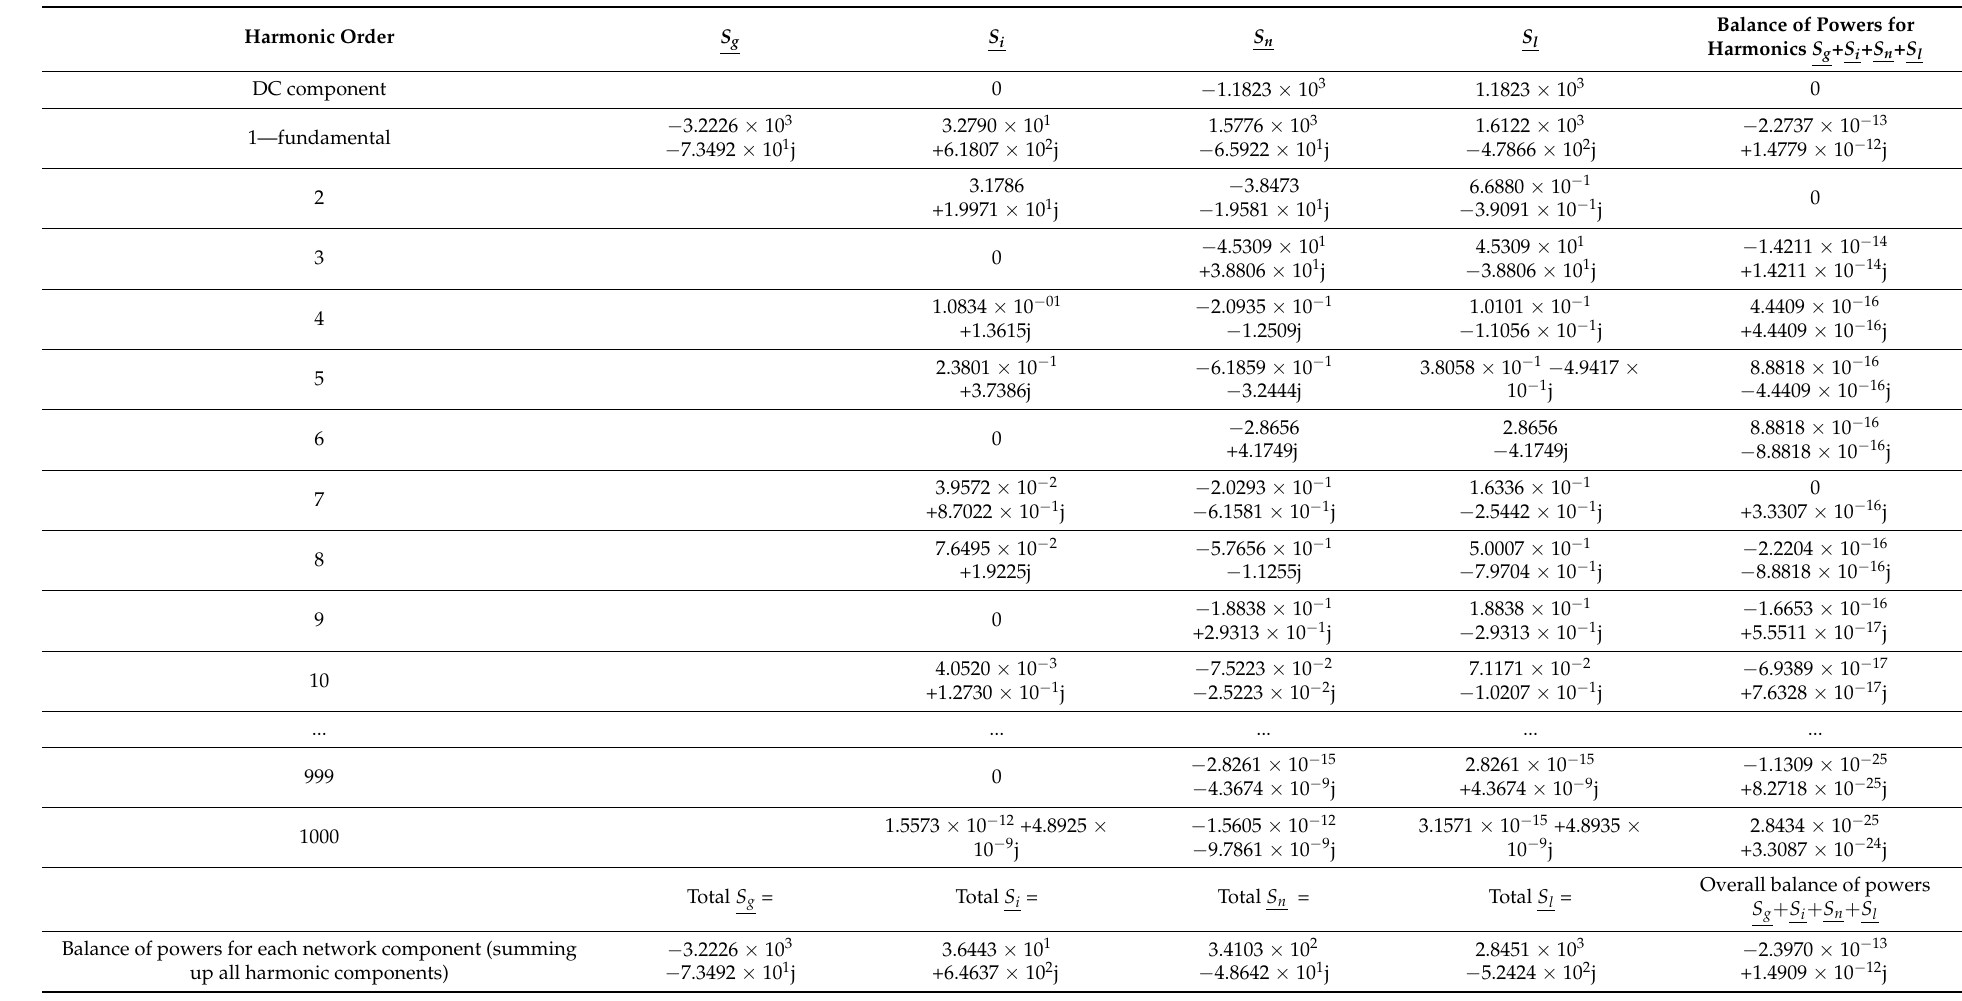
Table 2. Balance of complex powers for illustrative example 2 (different reactance values on symmetrical sequences for the fundamental and higher harmonics). Note that the real part of the complex powers corresponds to the active power transfer (unit (W)) and the imaginary part corresponds to the reactive power transfer (unit